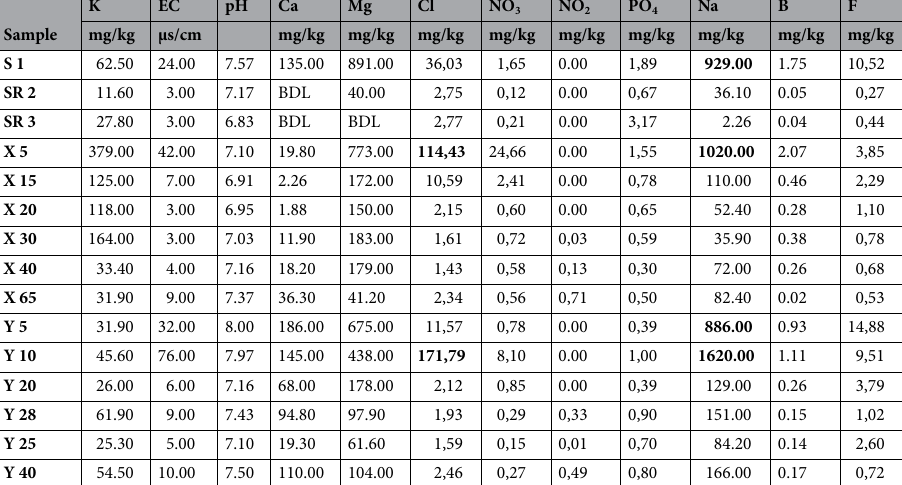
Table 7. Chemical parameters in the leachate obtained from leaching experiment. BDL Below detection Limit, S surface soil, SR surface rock, X borehole BH1 depth, Y borehole BH2 depth